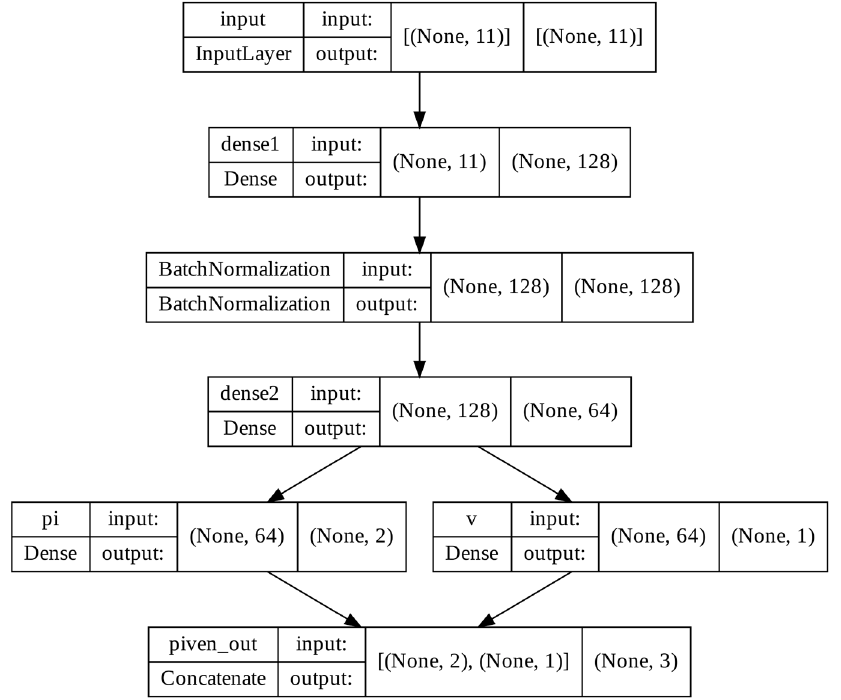
Figure 12. PIDNN architecture for SKD obtained from the Keras API. The same architecture is used both in the phase of selecting the most informative features and in the working mode. The only difference is in the number of inputs: 36 in the feature engineering phase and 11 in the working mode.